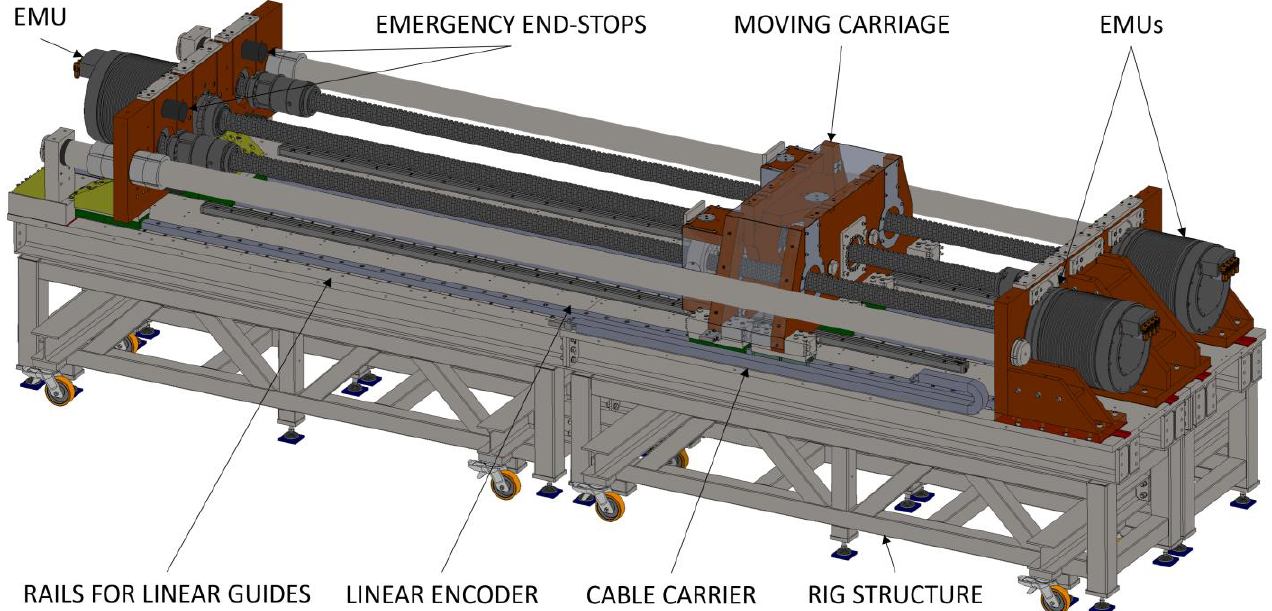
Fig. 12. HIL test rig mechanical assembly (3D view from